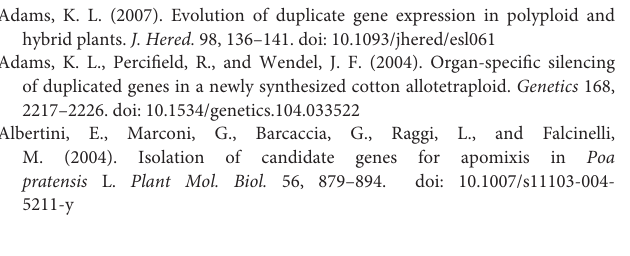
TABLE S8 | Nucleotide diversity and expression pattern of TEs expressed in H. perforatum ovules. For each locus ID, transcript variants displaying no significant expression differences between sexual and aposporous samples are also reported. For each transcript, the locus ID in our reference genome, the alignment start/end and the number of allele variants are also reported. aln pident: percentage sequence identity in the aligned portion of the transcript. PCC: Pearson correlation coefficients between aln_pident and FDR p -value. TABLE S9 | Expression pattern of transcripts potentially involved in epigenetic regulation of gene expression. For each locus ID, transcript variants displaying no significant expression differences between sexual and aposporous samples are also reported. For each transcript, the locus ID in our reference genome, the alignment start/end and the number of allele variants are also reported. repBD: annotations regarding reproductive processes (Galla et al., 2017). GOrep: ontological annotations related to reproductive processes. Gene annotations were downloaded from AmiGO2 (http://amigo.geneontology.org/amigo). Epigenetic mod: annotations related to genes involved in epidenetic regulation of gene expression as reported by Pikaard and Mittelsten Scheid (2014). The average expression of each transcript in sexual (sexual – means) and aposporous (aposporous – means), together with Bonferroni and FDM p -values corrections associated to GE analyses are also reported. TABLE S10 | Expression pattern of transcripts annotated as RNA binding. For each locus ID, transcript variants displaying no significant expression differences between sexual and aposporous samples are also reported. For each transcript, the locus ID in our reference genome, the alignment start/end and the number of allele variants are also reported. repBD: annotations regarding reproductive processes (Galla et al., 2017). GOrep: ontological annotations related to reproductive processes. Gene annotations were downloaded from AmiGO2 (http://amigo.geneontology.org/amigo). Epigenetic mod: annotations related to genes involved in epidenetic regulation of gene expression as reported by Pikaard and Mittelsten Scheid (2014). The average expression of each transcript in sexual (sexual – means) and aposporous (aposporous – means), together with Bonferroni and FDM p -values corrections associated to GE analyses are also reported. TABLE S11 | Graphical Representation of A. thaliana log transformed clustered data. For each gene/probe ID, the table reports on the unique experiment ID (UNIQID), the research area, the plant growth stage, the tissue and Arabidopsis ecotype adopted for the expression study. For each gene, references to the manuscript table and/or figure are also reported. A. thaliana gene expression data were retrieved from the BAR Expression Browser (http://bar.utoronto.ca/affydb/cgi-bin/affy_db_exprss_browser_in.cgi) (Toufighi et al., 2005). The output displays the average expression of replicate treatments relative to average of the appropriate control. Expression data were downloaded as graphical representation of log transformed clustered data. TABLE S12 | Primers used in this study. For each target gene, the forward and reverse primers are reported. The purpose of each primer combination is also